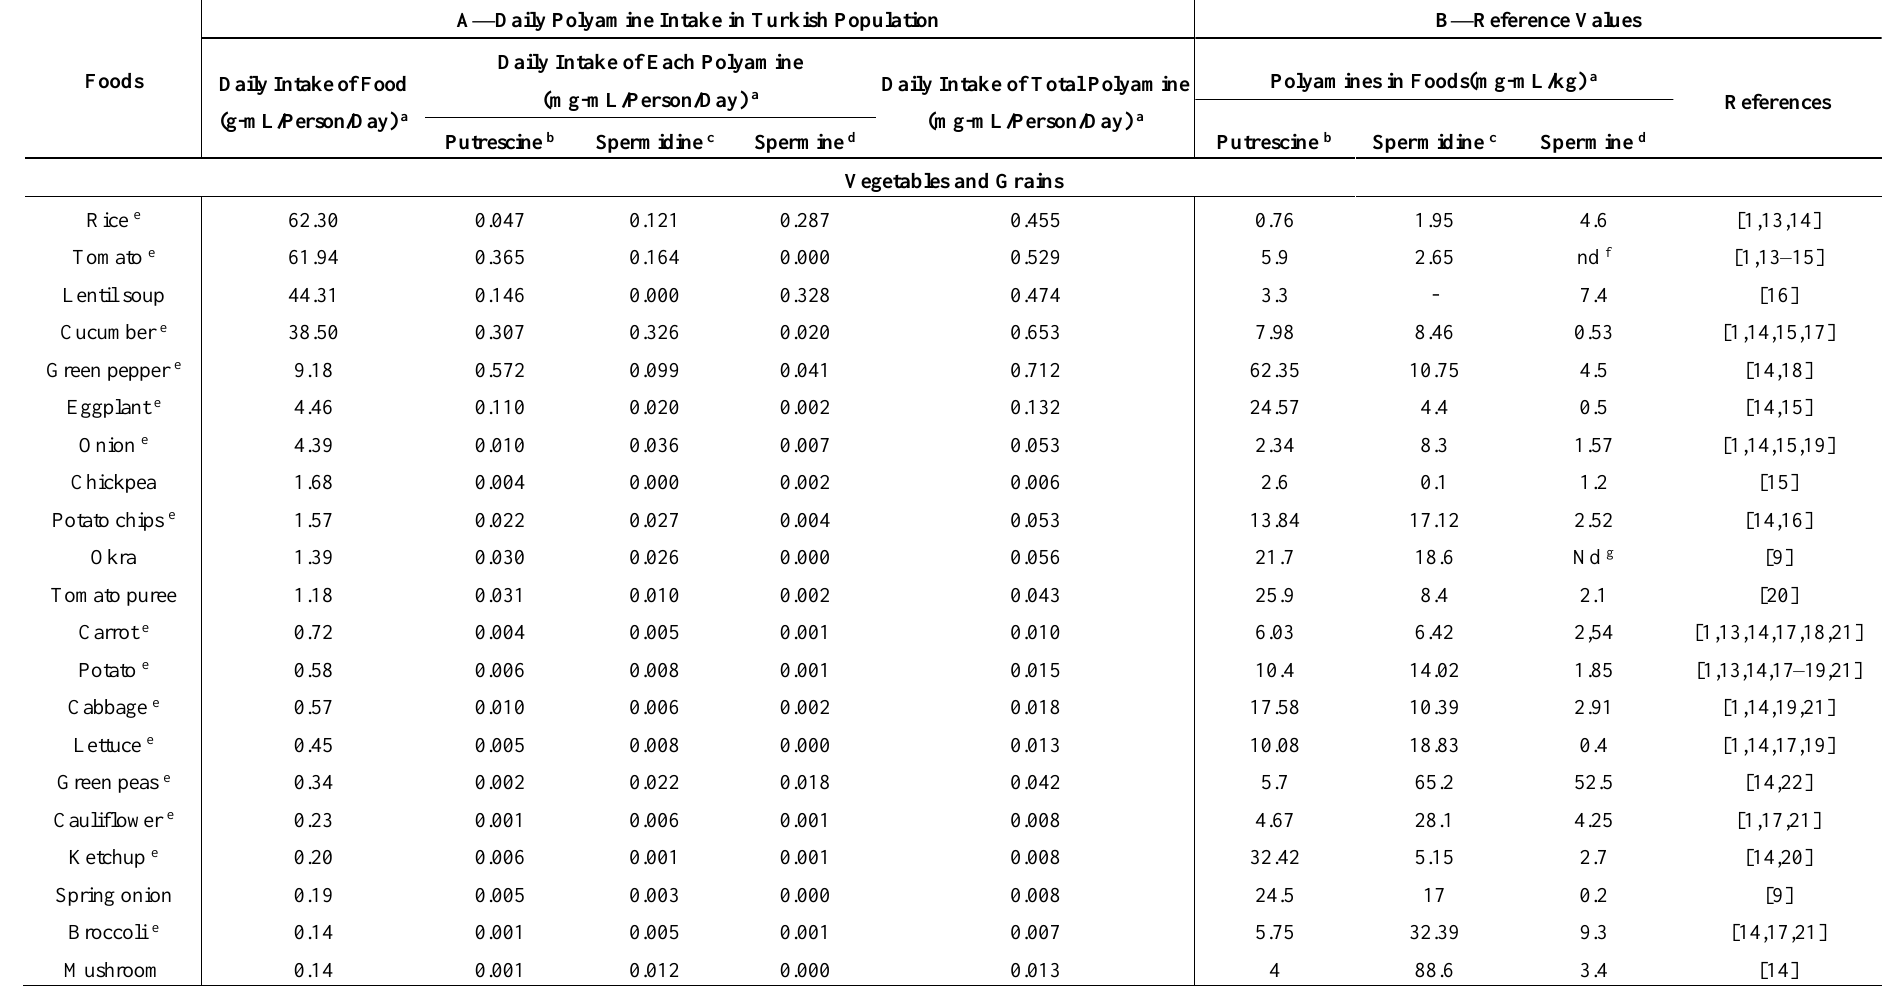
Table 1. Daily polyamine intake based on the reference values in the most frequently consumed foods in the Turkish